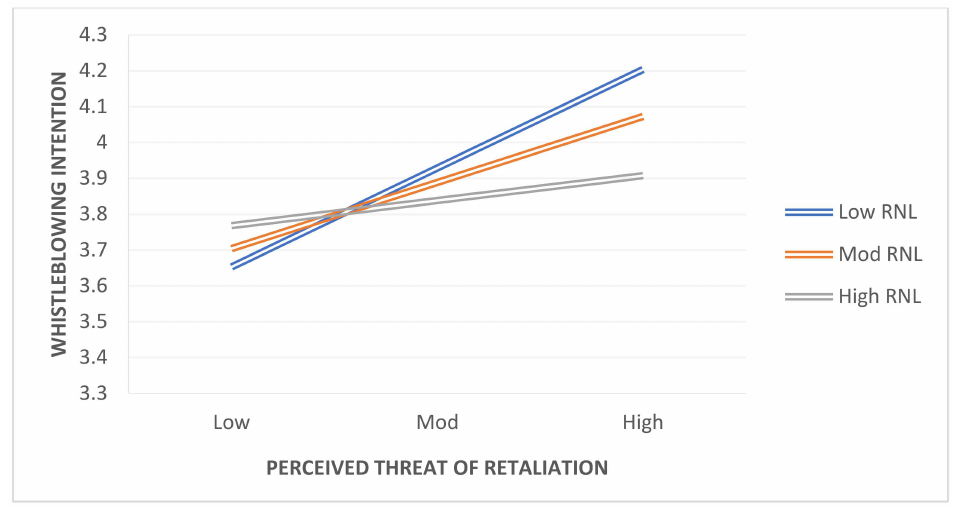
Figure 3. PTR*RNL = Whistleblowing